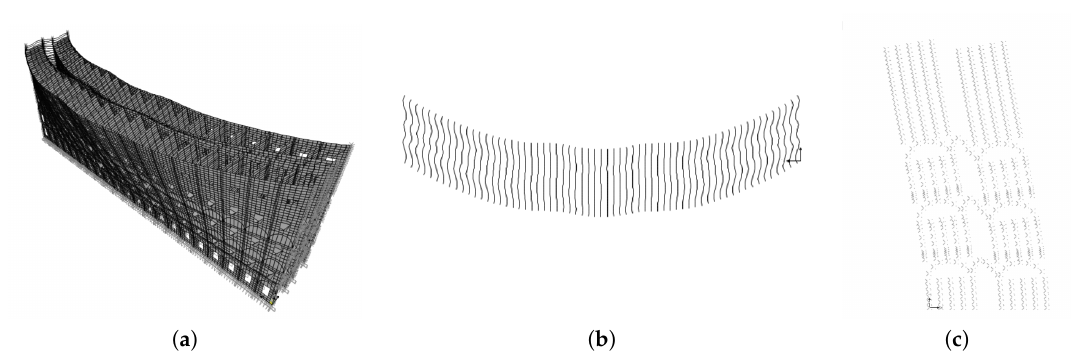
Figure 17. First natural mode of the SLTW fine model. Natural frequency f = 1.42 Hz. Modal shape in the: ( a ) 3D space; ( b ) x − z plane; ( c ) y − z plane.